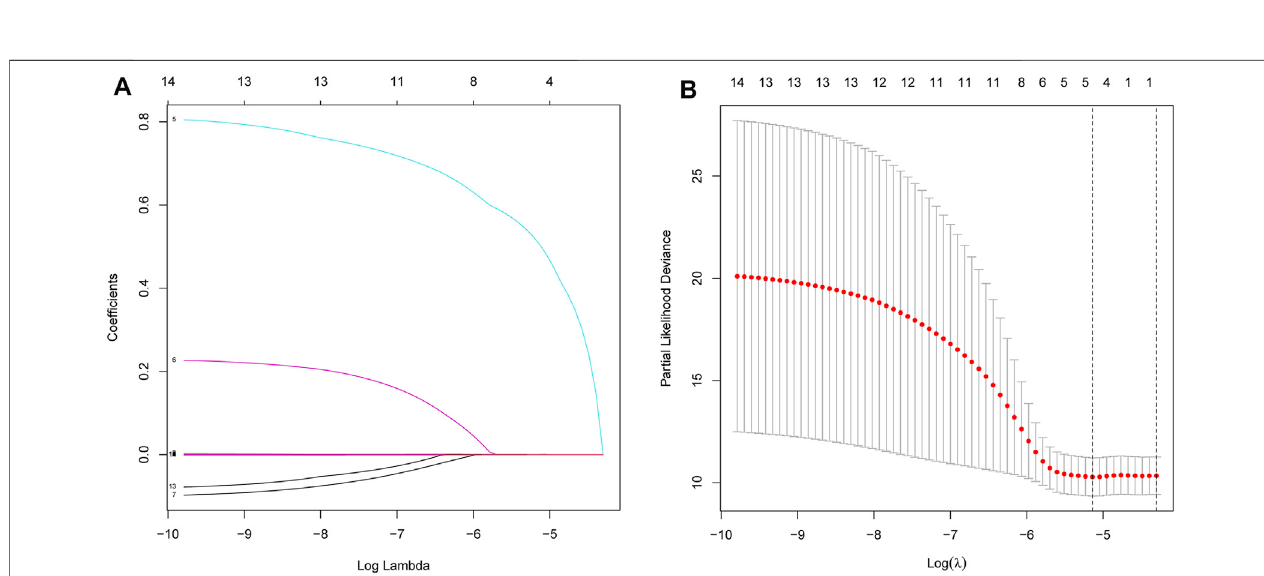
FIGURE 1 | Identi fi cation of the candidate genes. (A) . Heatmap showing differentially expressed genes between the two groups. (B) . The relationship among necroptosis-related DEGs.